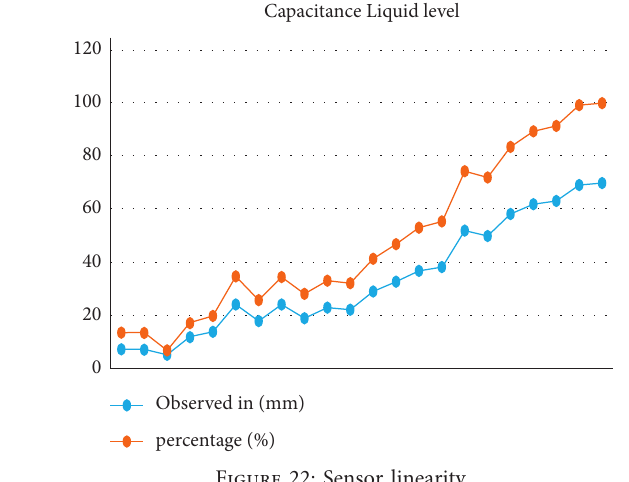
Figure 22: Sensor linearity.